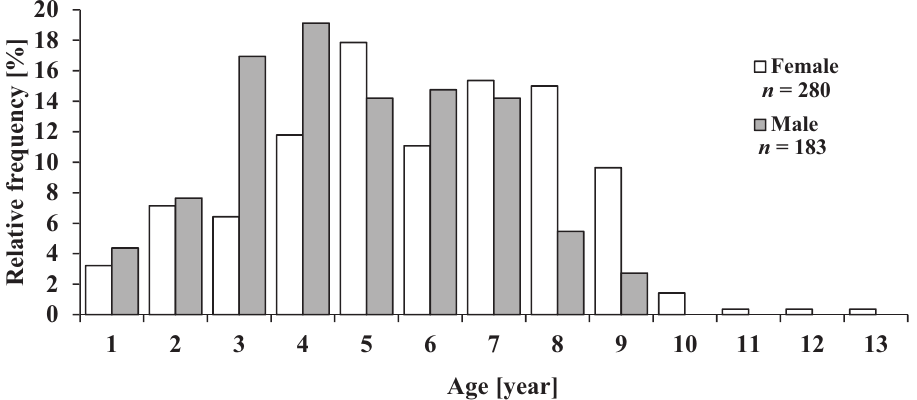
Figure 5. Age structure of Pacific hake, Merluccius productus , in the Gulf of California.